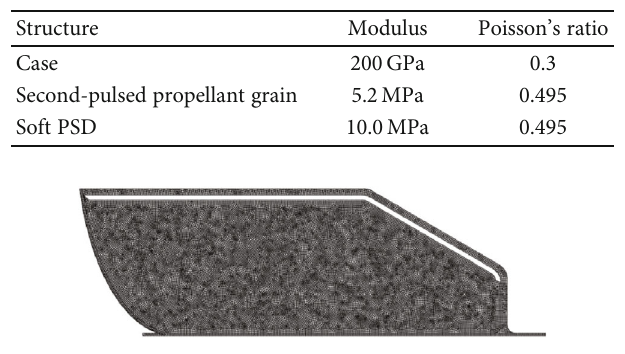
Figure 7: Model overall grid.